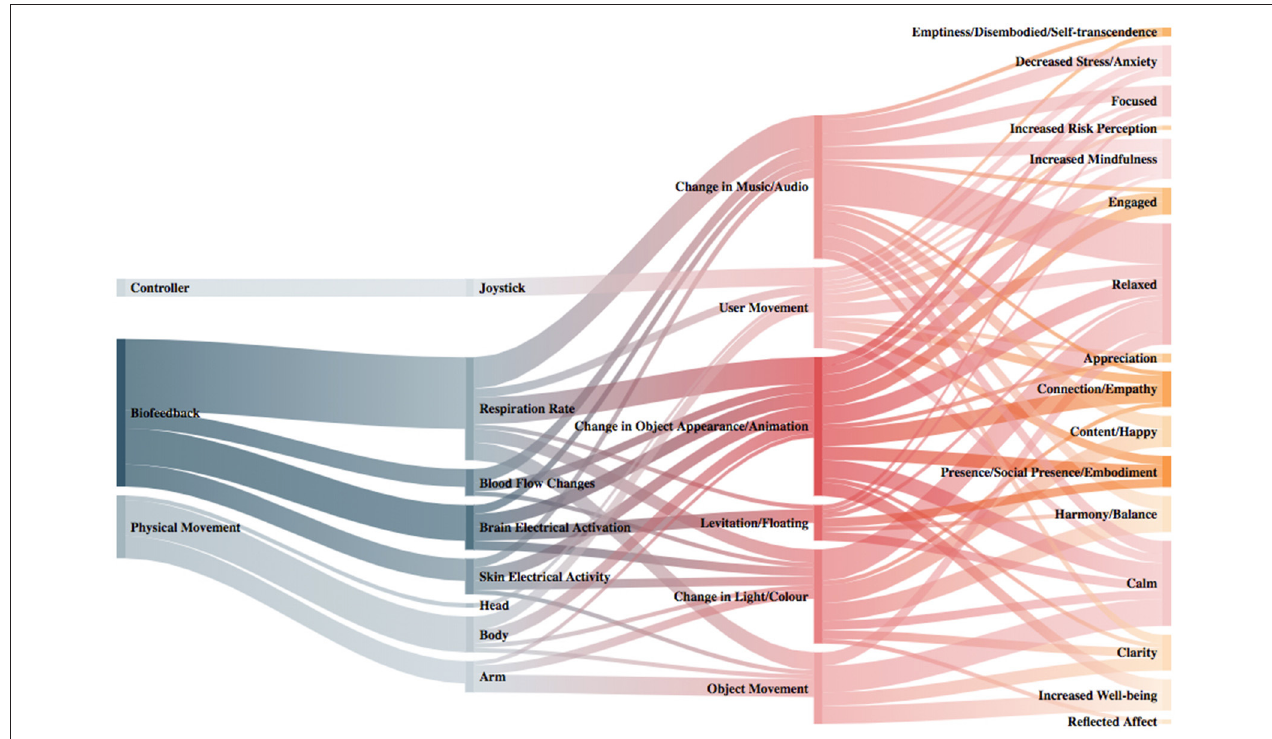
FIGURE 5 | Sankey diagram showing the input-output modalities and their corresponding outcomes for all experiences. Please note that some experiences use multiple types of input-output modalities, and some inputs correspond to multiple outputs and outcomes. Color intensity and stroke breadth indicate number of experiences for that category going left to right. This figure represents a static image of the data. For an interactive diagram that shows the number of experiences for each category, please see